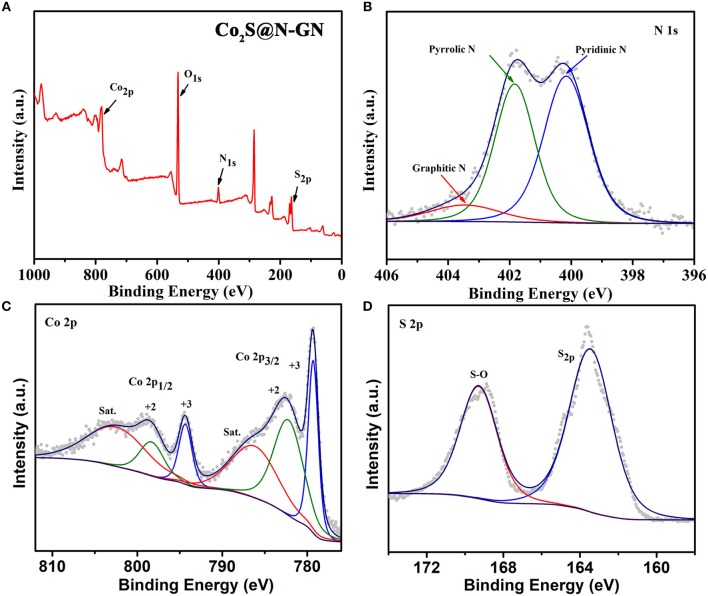
(A) XPS survey, (B) N 1s, (c) Co 2p, and (D) S 2p XPS spectra of the CoS2@N-GN hybrid.